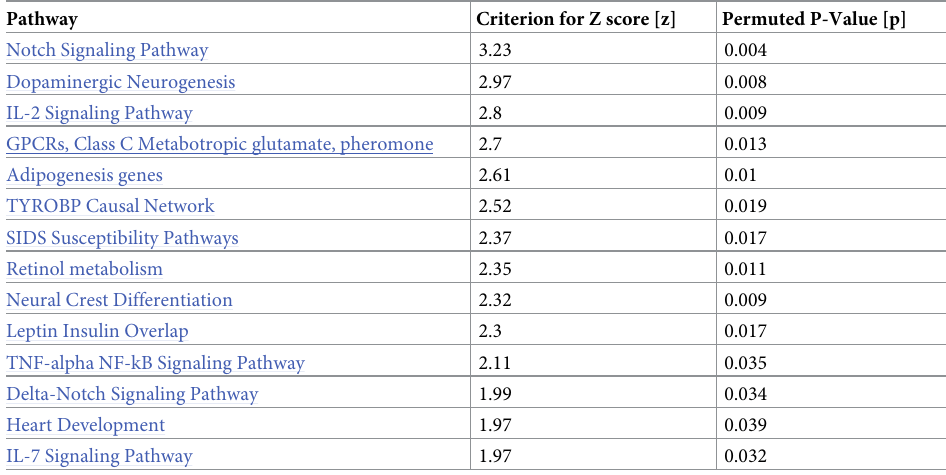
Table 1. Pathway statistics: G1_SGE_vs_control, fold change > 4.